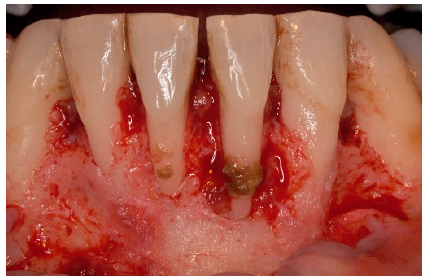
Figure 3. Approach was achieved by raising a single buccal flap, calculus on the denuded root surfaces and large loss of periodontal support are evident.